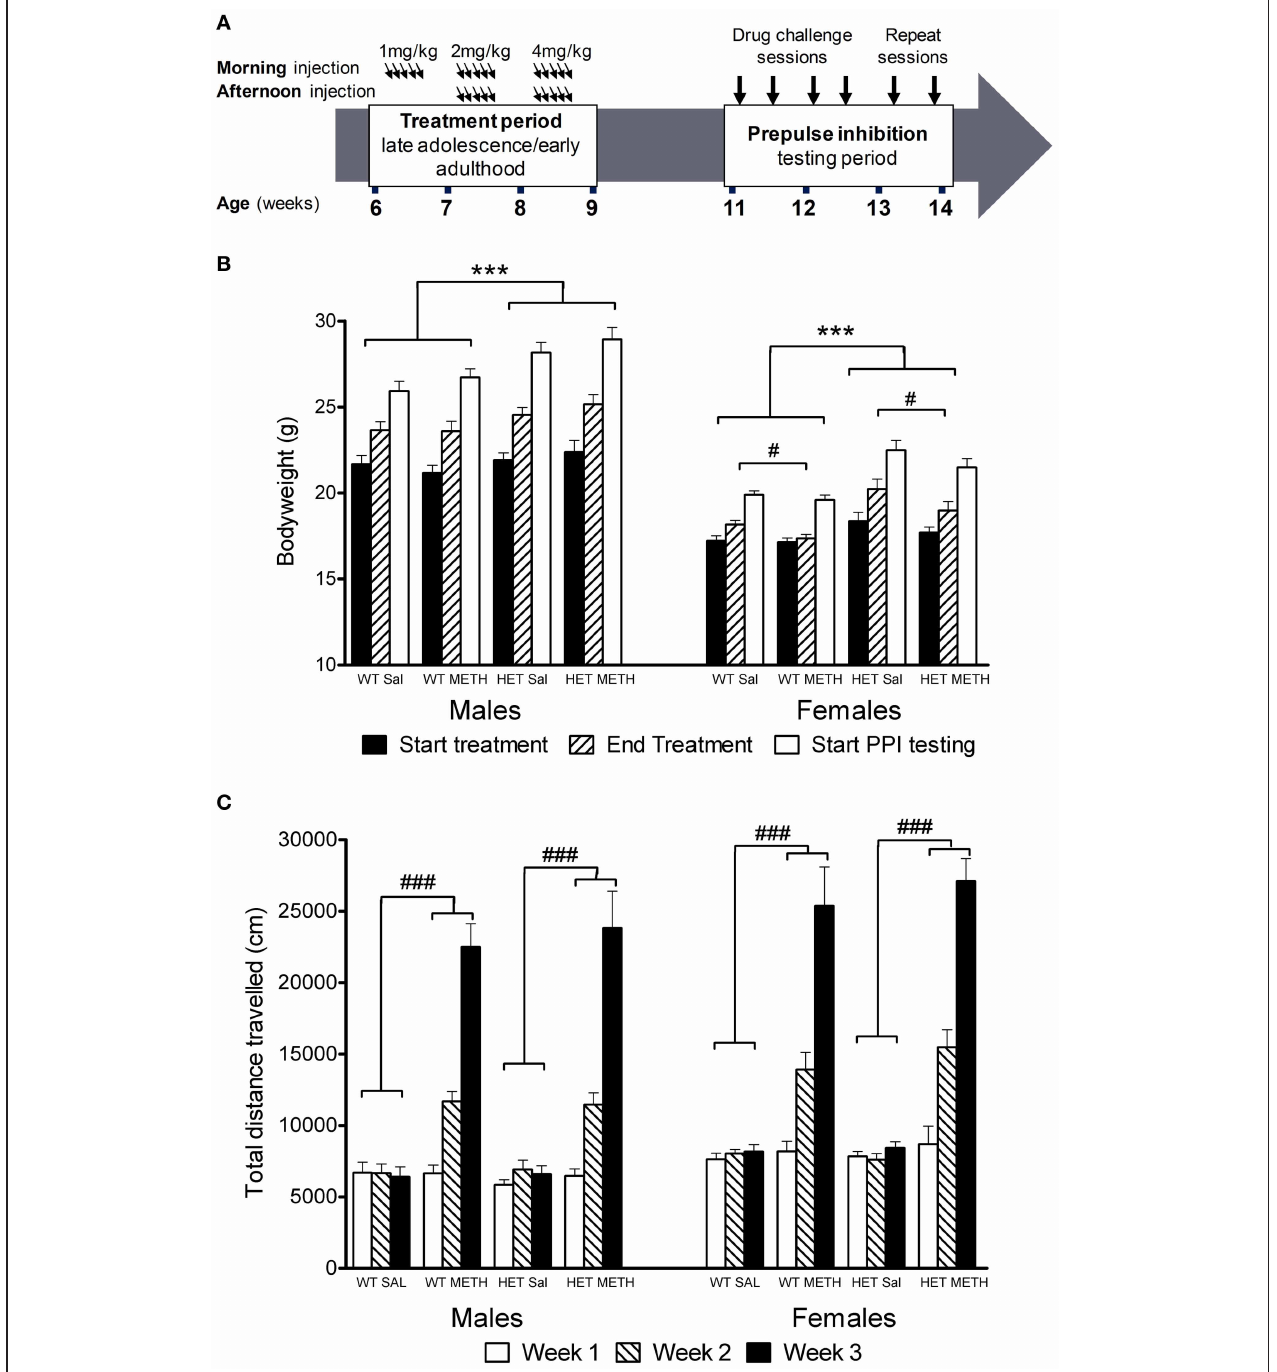
FIGURE 1 | Experimental timeline, bodyweight change, and locomotor activity during the treatment period. (A) Mice were treated with saline or an escalating dosing regime of METH from 6 to 9 weeks of age, i.e., during late adolescence/early adulthood. Following a 2-week break, the animals were tested in four PPI sessions following challenge treatment with either saline, AMPH, APO, or MK-801 in pseudorandomized order. (B) Bodyweight at the start or end of the chronic METH/saline treatment and at the start of PPI testing. BDNF HETs were significantly heavier than their WT littermates throughout the experiment. At the end of the